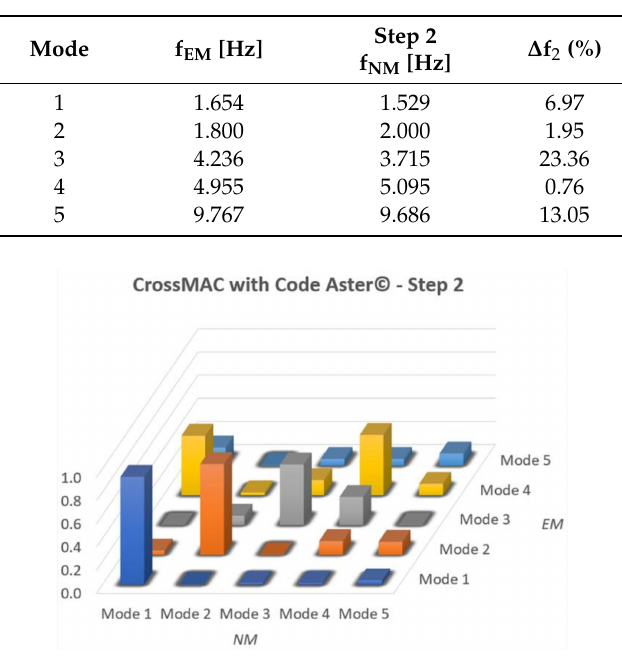
Figure 14. CrossMAC between EM and NM at step 2 with Code Aster ©